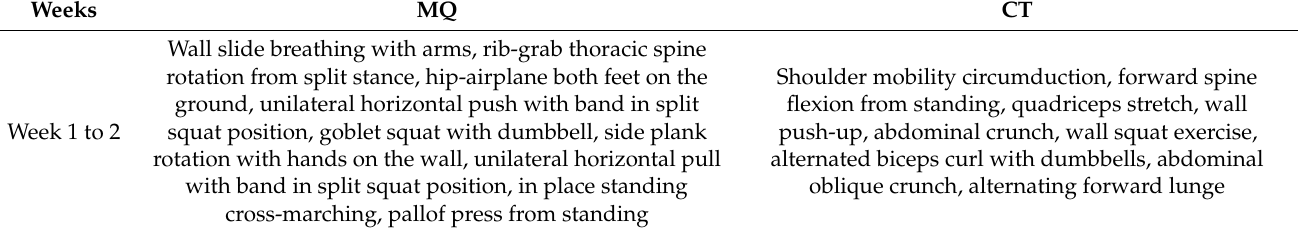
Table 1. Training content of the 6-week intervention performed by MQ and CT